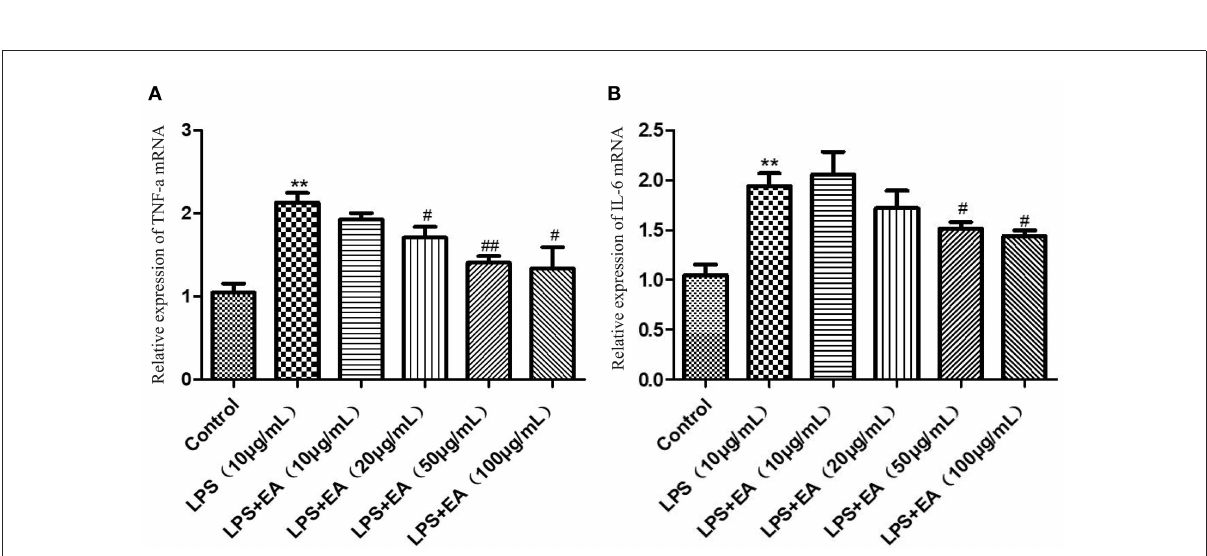
FIGURE11 The expression levels of TNF- α and IL-6 mRNAs in LPS-induced IPEC-J2 cells treated with different concentrations of EA. (A) The expression levels of TNF- α mRNA; (B) the expression levels of IL-6 mRNA. Compared with the control group, ** means extremely significant difference ( P < 0.01); compared with the LPS group, # means significant difference ( P < 0.05), ## means extremely significant difference ( P <